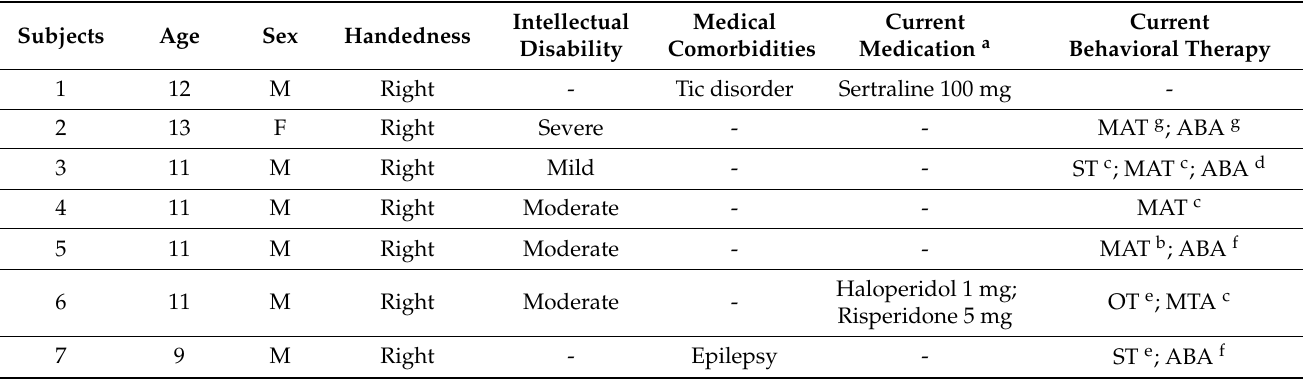
Table 1. Demographic and clinical characteristics of participants. OT, occupational therapy; MAT, multisystem aquatic therapy; ST, speech therapy; ABA, applied behavioral